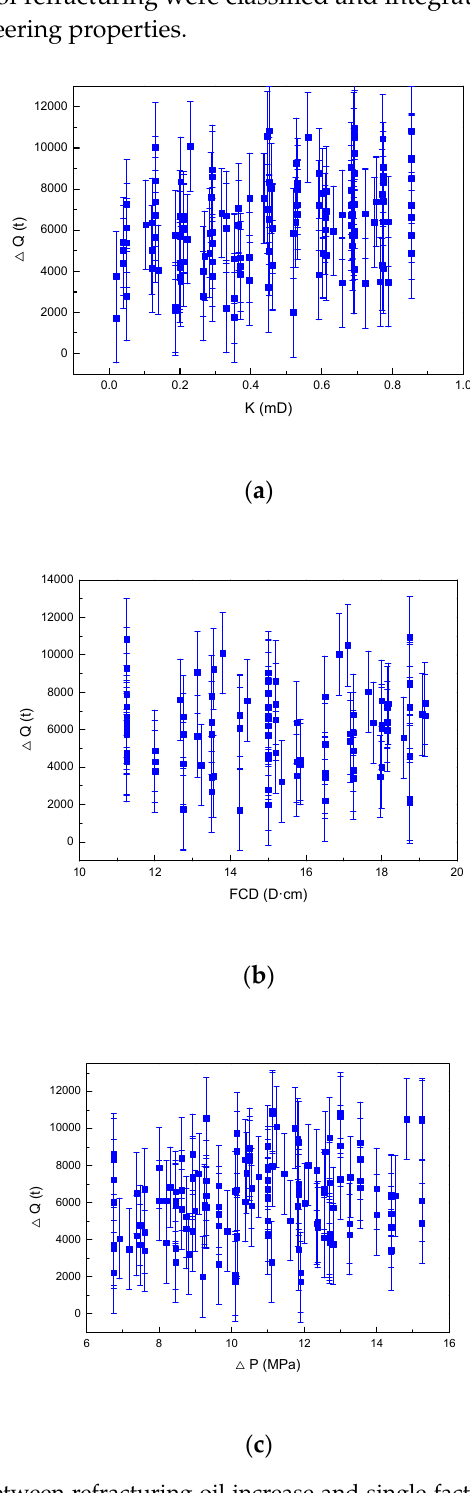
Figure 3. Relationship between refracturing oil increase and single factor: ( a ) Production increase versus permeability; ( b ) Production increase versus Fracture conductivity; ( c ) Production increase versus production pressure difference.